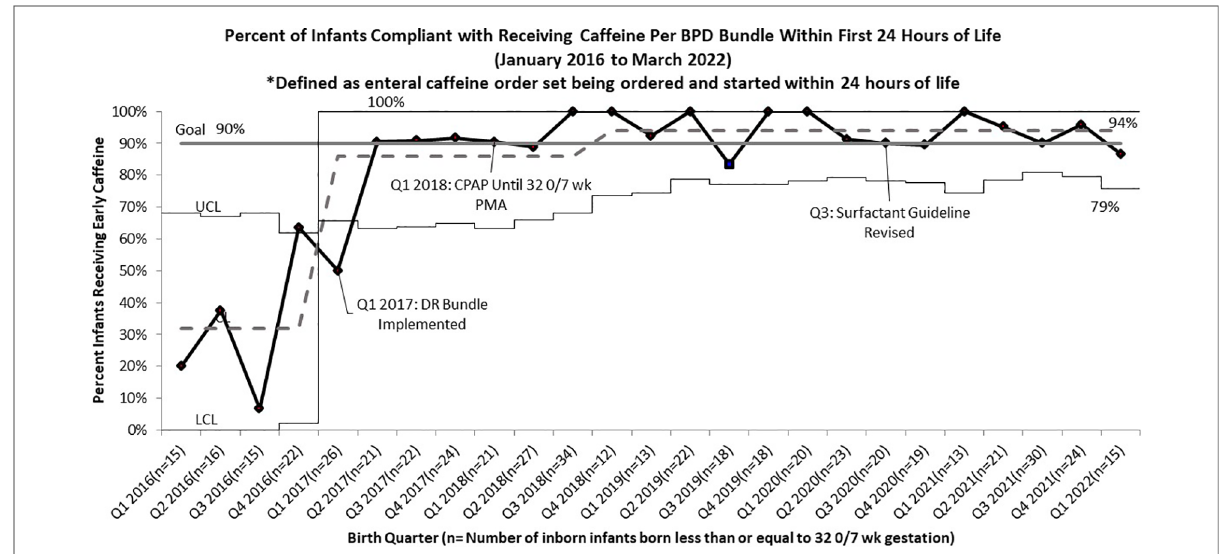
FIGURE 2 P chart of compliance with BPD bundle guidelines for infants born less than or equal to 32 0/7 Weeks Gestation to Receive Early Caffeine Within 24 h of life.